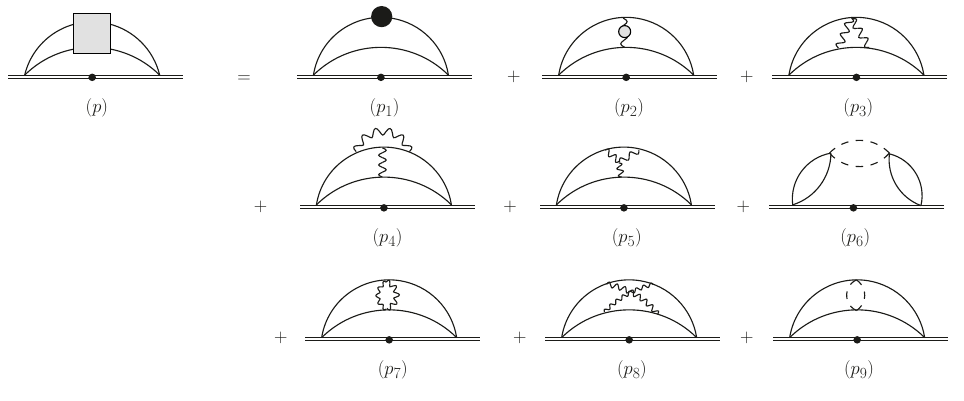
Figure 5. Scalar bubble